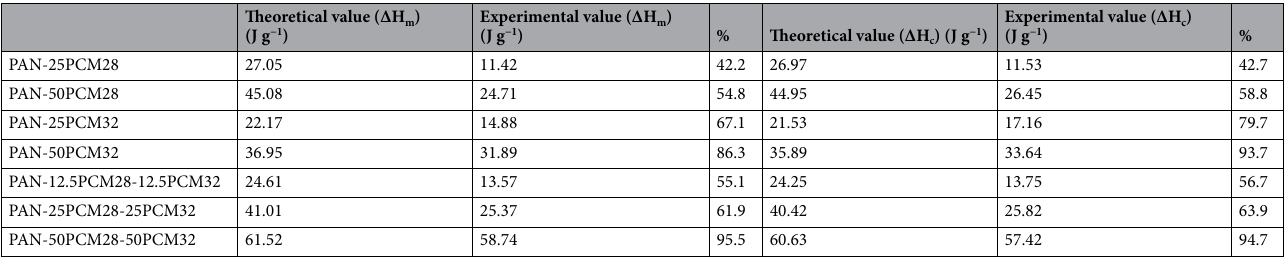
Table 5. Theoretical and experimental enthalpy